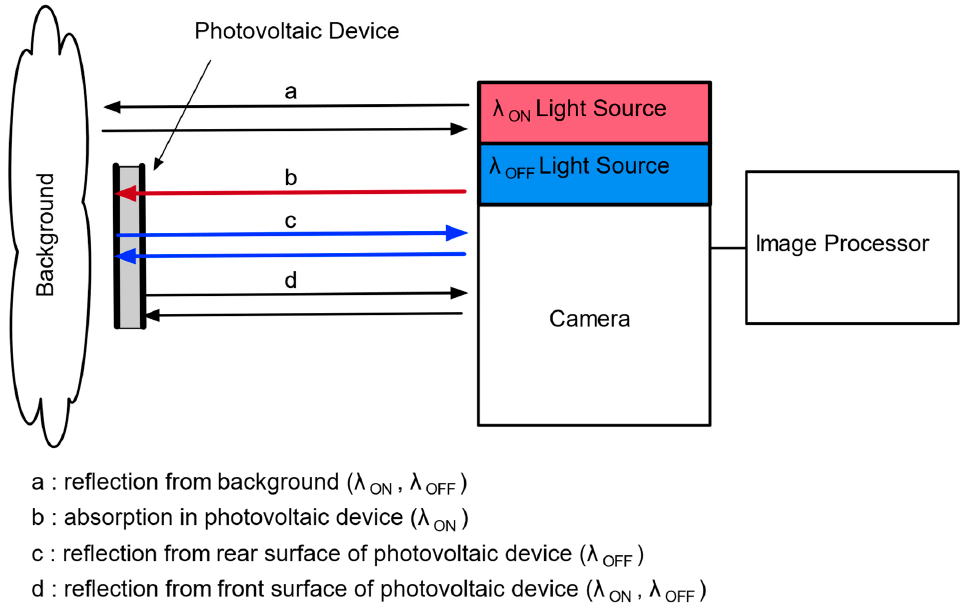
Figure 1. Principle of differential absorption image sensor.